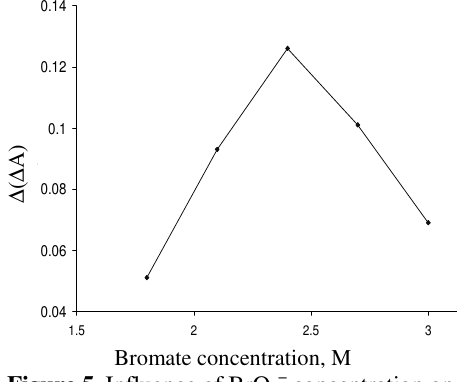
Figure 5 . Influence of BrO 3− concentration on the analytical signal.